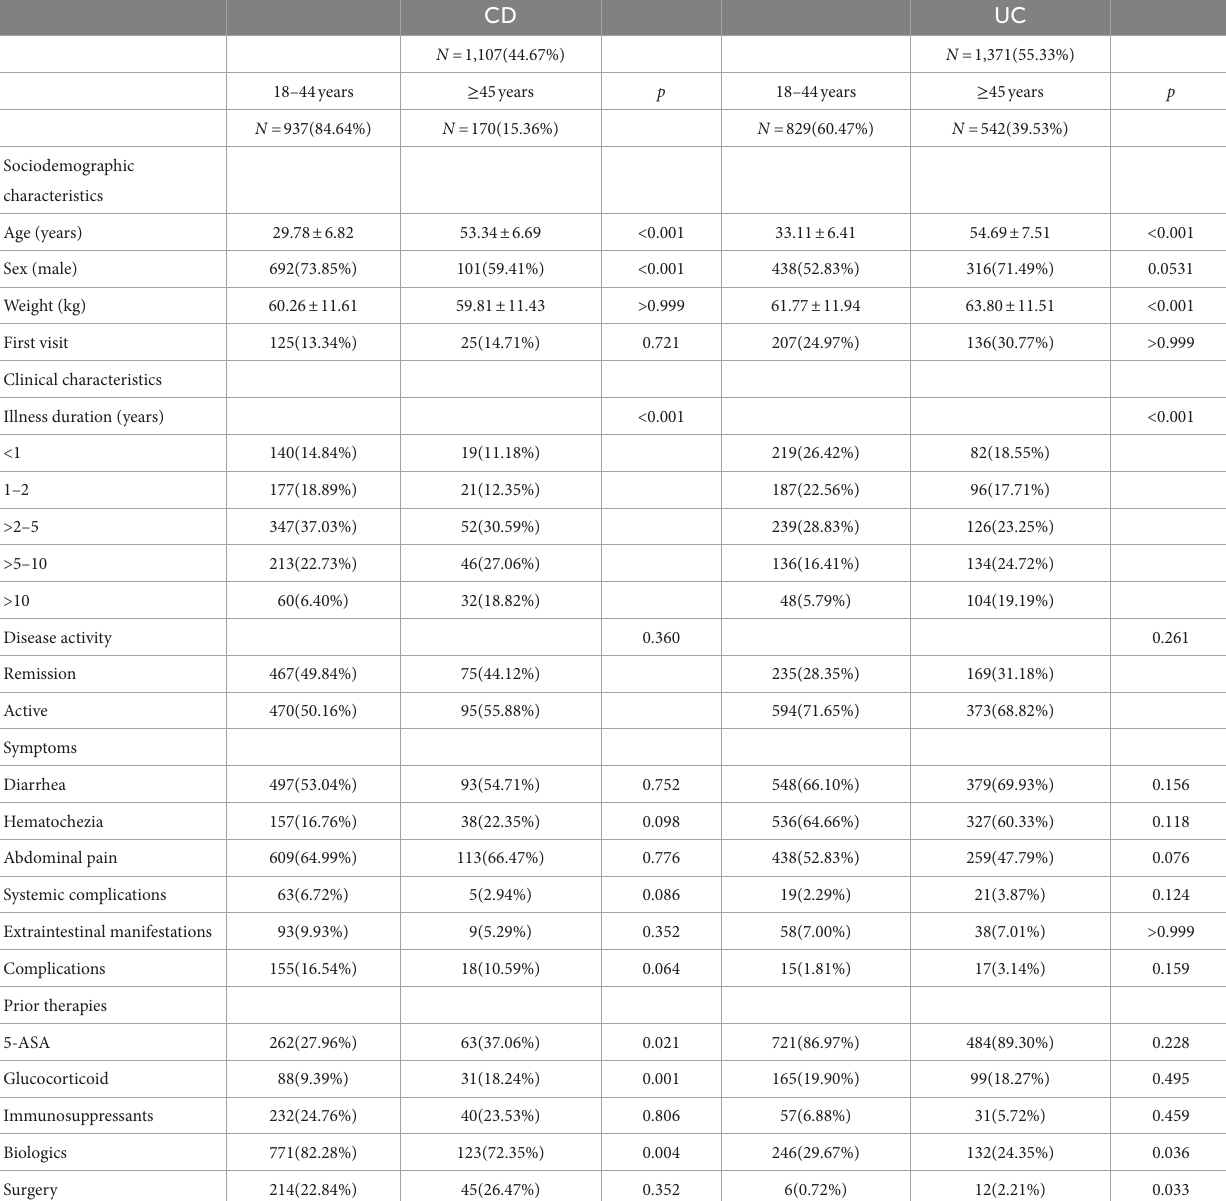
CD=Crohn’s disease; UC = ulcerative colitis; IBD = inflammatory bowel disease; ASA = amino salicylic